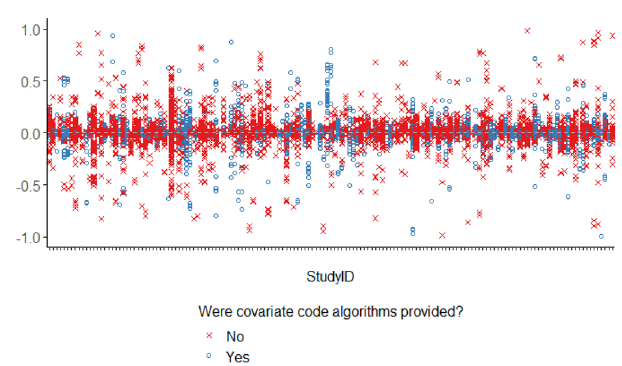
Fig. 2 | Difference in prevalence of baseline characteristics (original − repro- duction). Each column represents covariates from a different study. Each point represents the difference in corresponding cell values from tables describing characteristics of the cohort in the original paper and the reproduction. Dashed horizontal gray line at 0.0 re fl ects no difference in prevalence of baseline char- acteristicbetweenoriginalandreproductioncohorts.Sourcedataareprovidedasa Source Data fi le.